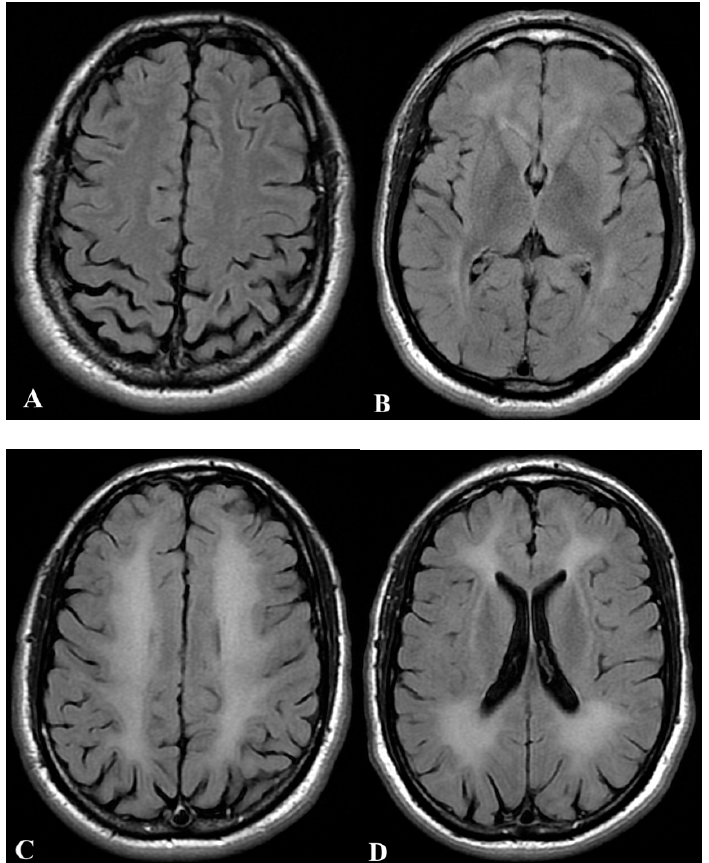
Figure 1. Brain Magnetic Resonance (MRI) two weeks after the carbon monoxide intoxication ( A , B ) showed no abnormalities; brain MRI after the development of neurological syndrome ( C , D ) showed bilateral and extended alteration of the supratentorial, periventricular, and centrum semiovale white matter, with hyper ‐ intensity in Fluid ‐ attenuated inversion recovery (FLAIR).